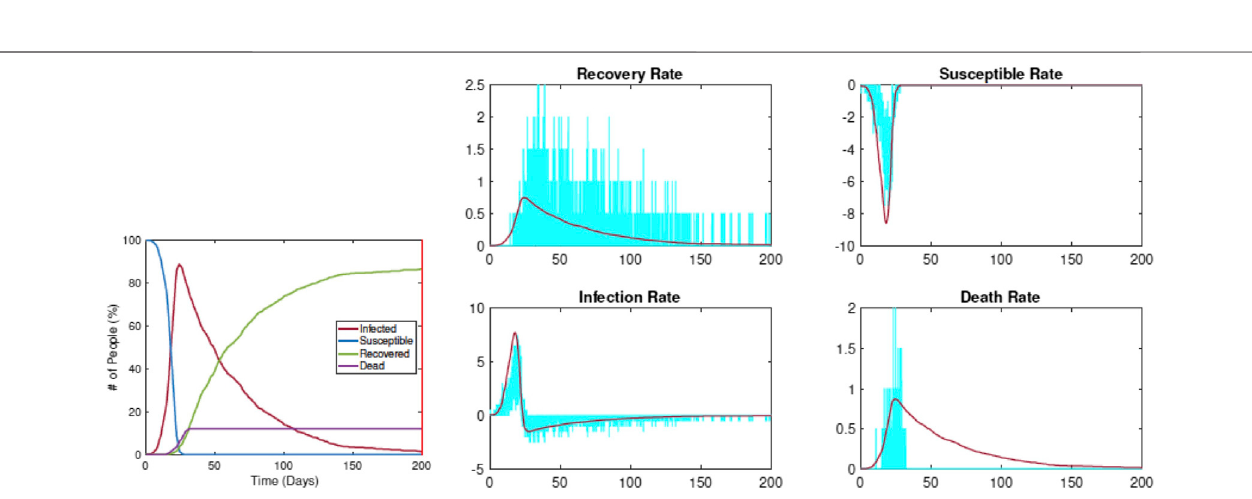
FIGURE 5 | Estimation of SIRD parameters from data simulated by RAW-ALPS for an unconstrained spread. The pandemic curves generated by the SIRD model with estimated parameters match the RAW-ALPS output.